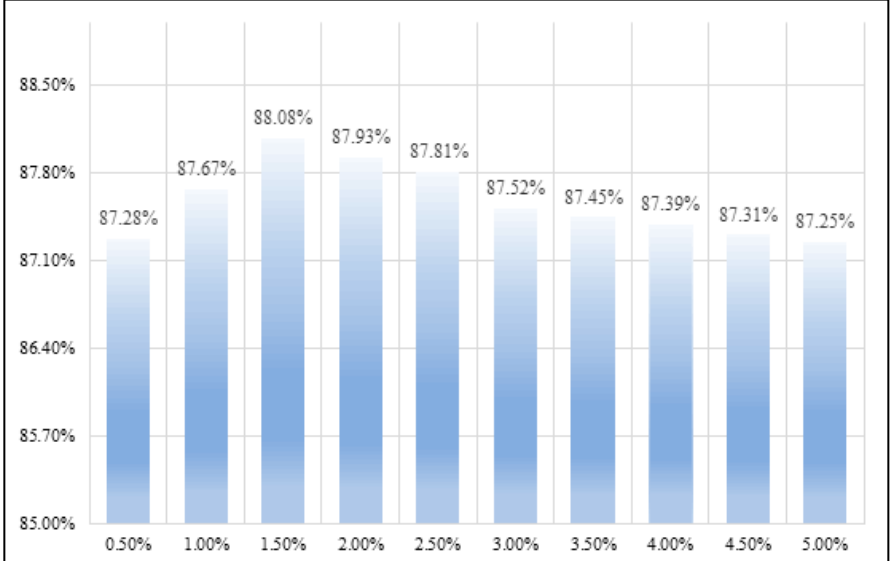
Figure 9. Inter-class imbalance